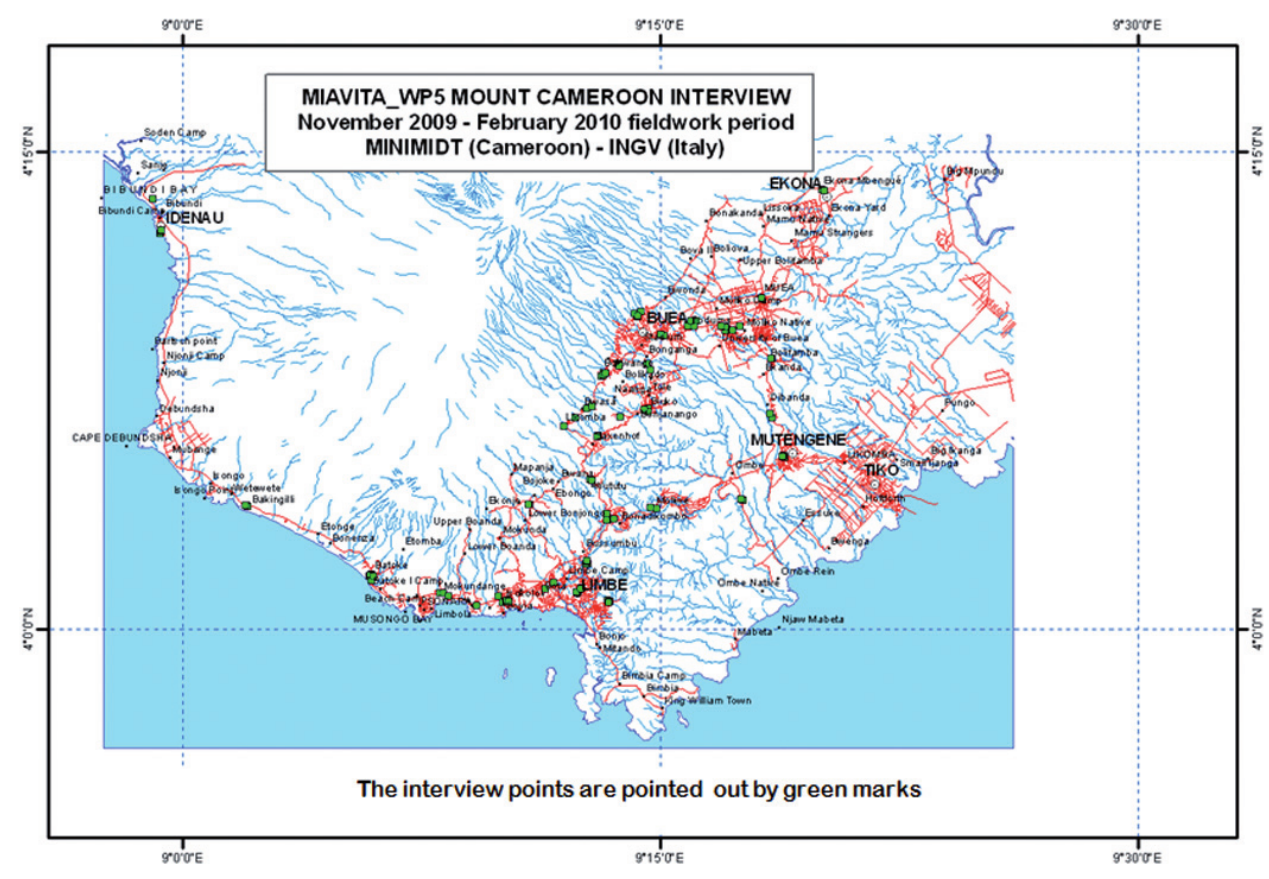
Figure 6. Interactive GIS environment of the Ministry of Industry, Mines and Technological Development produced after the first fieldwork campaign (2009-2010) in the framework of the FP7 MIA-VITA